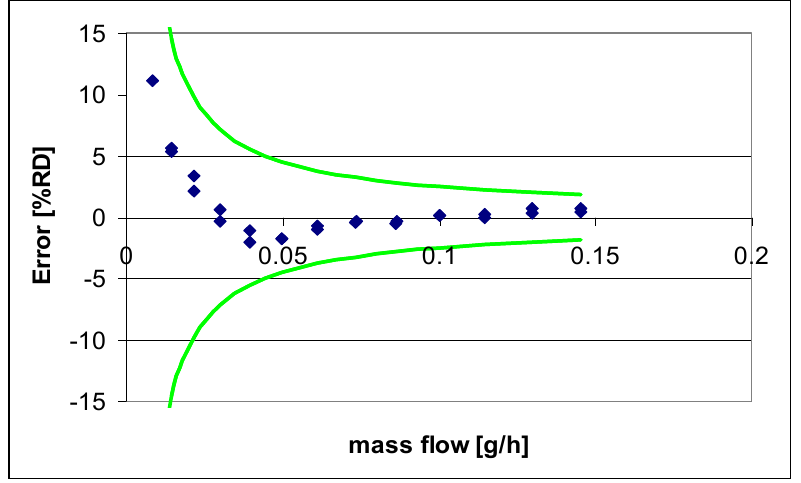
Figure 11. Measured hydrogen mass flow vs. piston prover. The envelope represents a zero stability of 2 mg/h and an accuracy of 0.5% reading. The pressure drop across the Coriolis mass flow meter was approximately 8 bar.